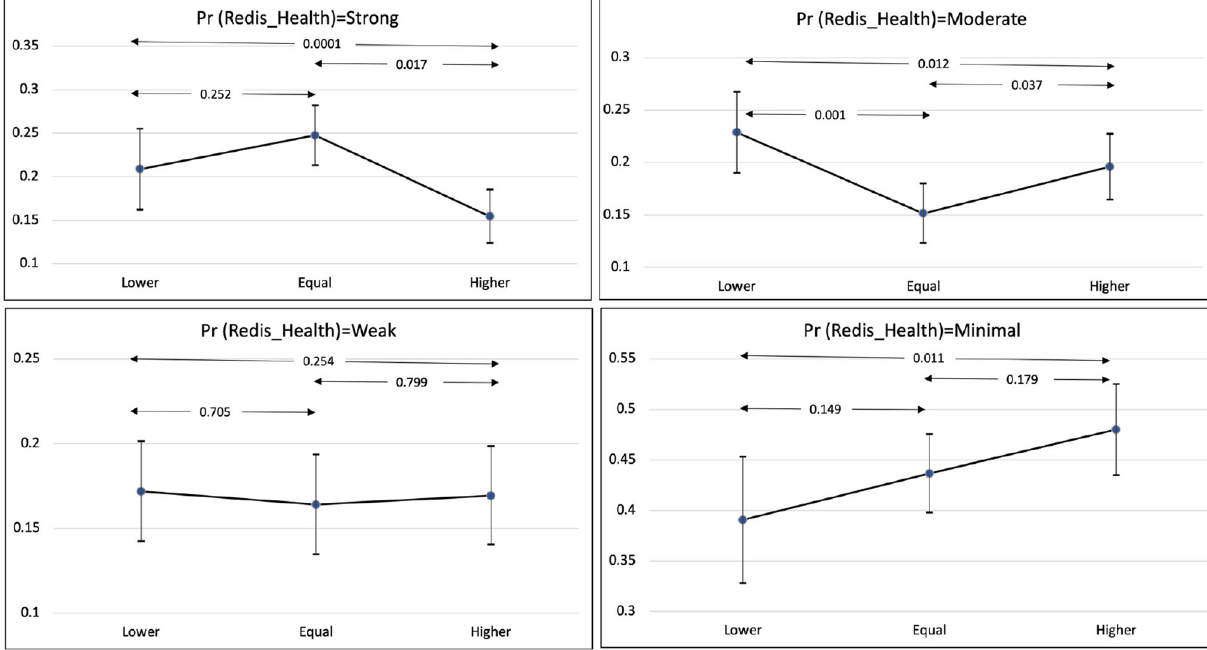
Fig. 2 Effect of inequalities in perceived brute luck on willingness to redistribute in favour of health. Each panel represents a level of redistribution (Strong, Moderate, Weak and Minimal). For each luck level (Lower, Equal, Higher), the predictive margin with 95% CI is presented. For each pair of luck levels, the number corresponds to the p -value of a bilateral equality test computed using delta predicted probability of support for a moderate level of redis- Figure 2 illustrates how the predicted probabilities for will- tribution in favour of the environment, and decreasing on the ingness to redistribute in favour of health changed with perceived predicted probability of support for a minimal level. No sig- brute luck. The average marginal effects of higher perceived brute ni fi cant pattern was found for the other two degrees of perceived luck were monotonically increasing on the predicted probability brute luck (moderate and weak). of support for a minimal level of redistribution in favour of